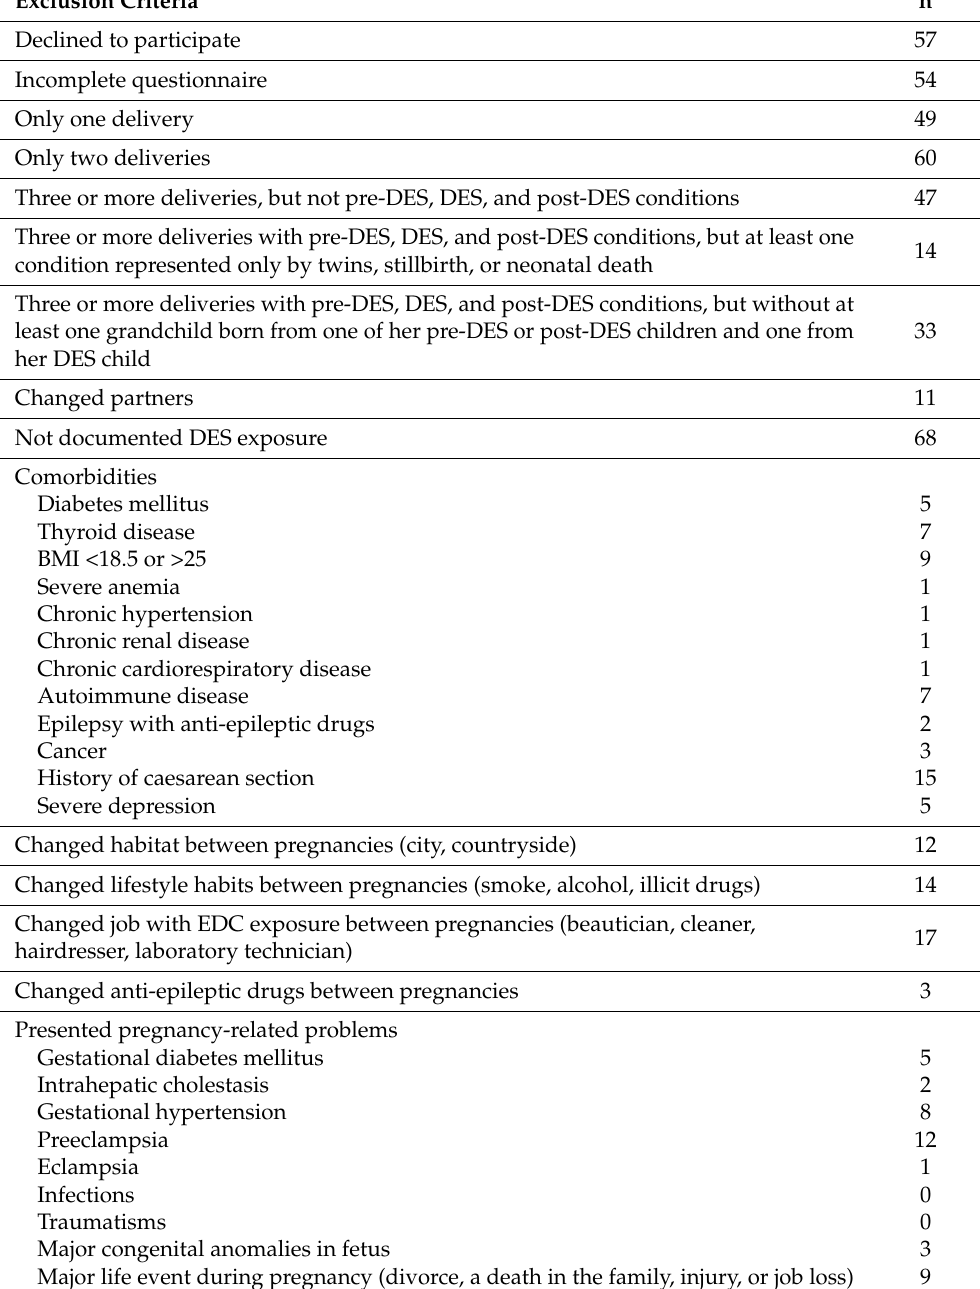
Table 1. Characteristics of the excluded